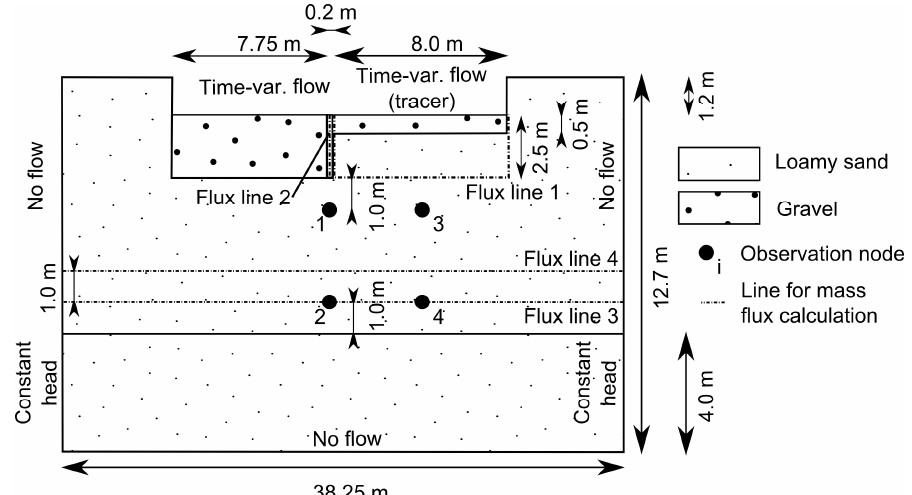
Figure 2. Conceptual reference model for closely-spaced infiltration, observation nodes 1–4, together Figure with mass flux lines 1–4 are also depicted, not to scale.